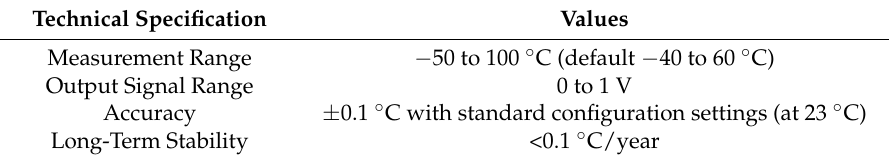
Figure 2. Temperature probe of the case study. Table 2. Technical specifications of the external temperature probe